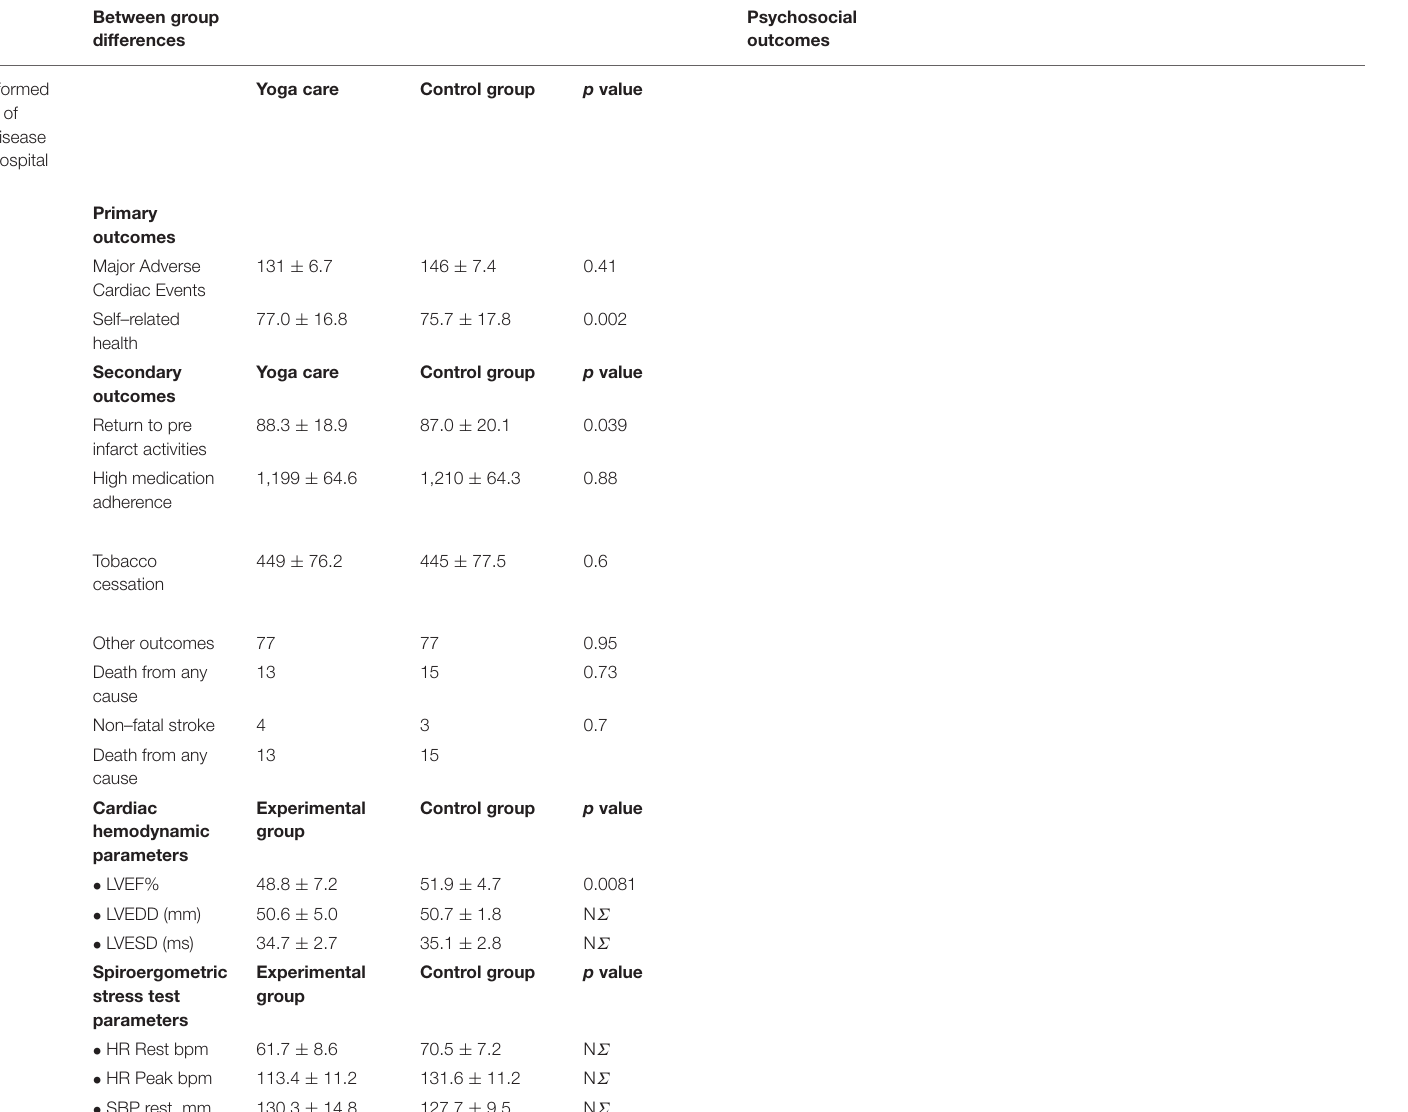
TABLE 4 | Description of physical and psychosocial outcomes and between group differences (yoga vs.